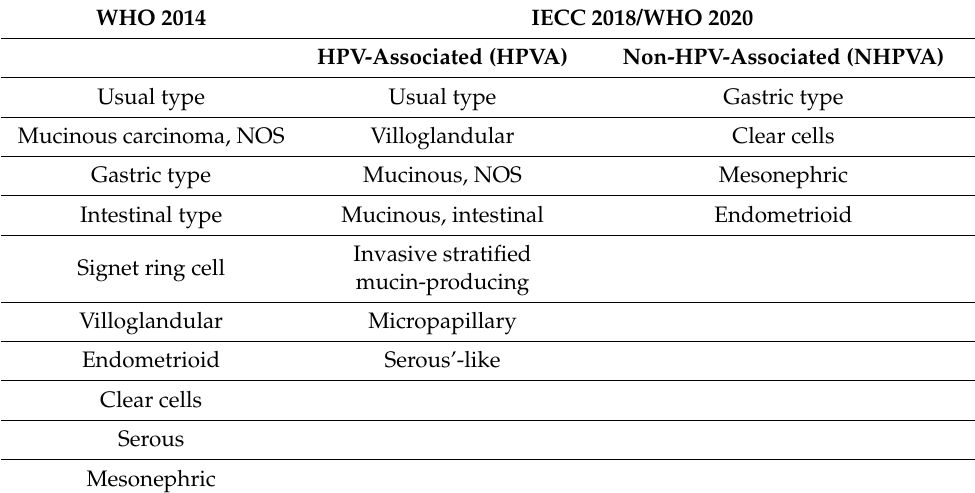
Table 2. Classifications of adenocarcinoma of the uterine